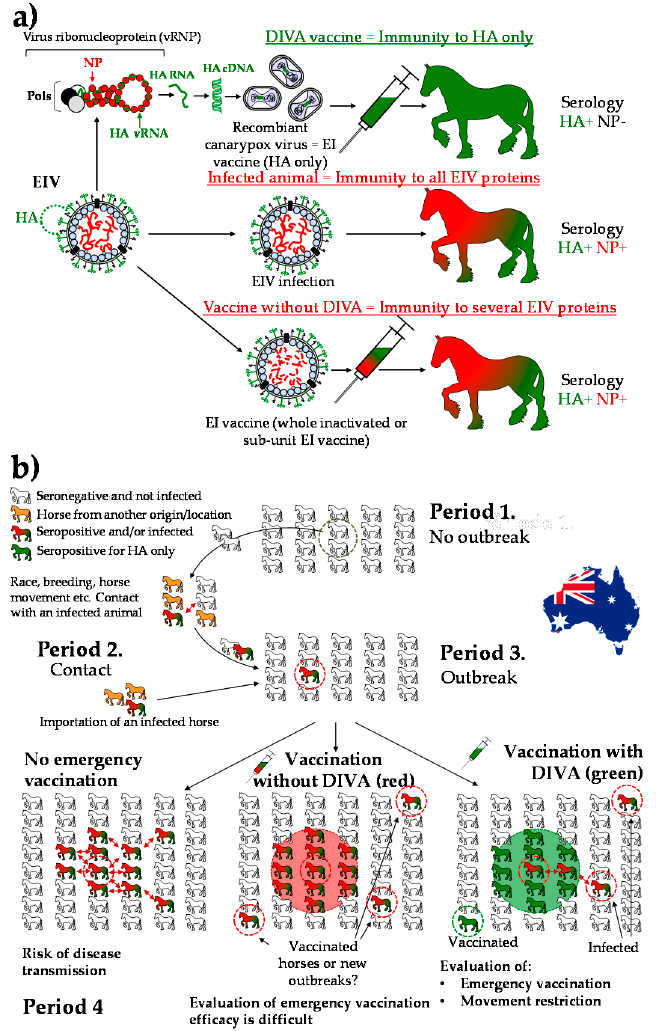
Figure 2. The importance of Differentiating Infected from Vaccinated Animals (DIVA). The use of an EI vaccine with DIVA capability is an asset to maintain an effective surveillance during an outbreak while emergency vaccination is implemented [3]. ( a ) The canarypox-based EI vaccine is a live attenuated canarypox virus with the EIV HA gene (green) inserted in its genome (one EIV HA per canarypox vector). The canarypox-based EI vaccine induces a seroconvertion limited to the EIV HA antigen after immunisation (green horse). Infection with EIV or immunization with whole inactivated or sub-unit EI vaccines induce a seroconvertion to several EIV antigens, including the EIV HA (green) and the nucleoprotein (NP, red) [12]; ( b ) An equid population naïve for EI (Period 1). Due to horse movement and/or importation of an infected animal (Period 2), an EI outbreak is detected (green + red horse, Period 3). Prevention and control measures are implemented (Period 4). In the absence of emergency EI vaccination, disease control relies primarily on movement restriction, active surveillance, biosecurity measures and is heavily dependent of the horse population density. A virus such as EIV is likely to spread quickly (especially in a naïve population such as in Australia in 2007). Emergency vaccination is implemented to support these measures. If an EI vaccine without DIVA capability is used (green + red vaccine), any seroconvertion (green + red horse) detected outside the vaccination buffer zone should be considered as a potential EI case (i.e., it is not possible to discriminate between a vaccinated horse that moved from the vaccination buffer zone or a new infected horse). The use of an EI vaccine with DIVA capability (green vaccine) allows to follow the spread of EIV infection inside the vaccination buffer zone, to identify real EI outbreak and infected horses (green + red horses) outside the vaccination buffer zone and to control the implementation of specific measures such as movement restriction.